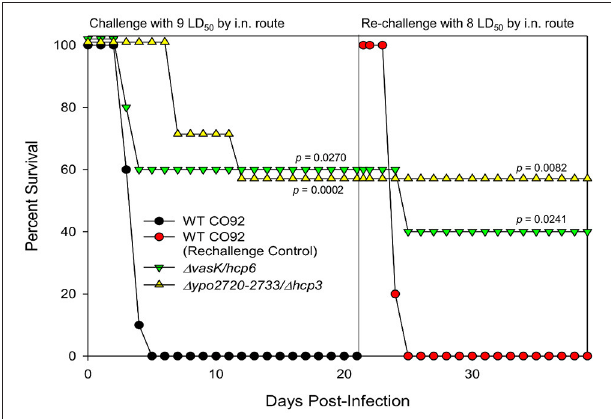
FIGURE 4 | Vaccine potential for selected Y. pestis CO92 combinational mutants . Female Swiss-Webster mice were challenged by the i.n. route with the WT CO92, 1 vasK 1 hcp6 , or 1 2720-2733/ 1 hcp3 ( n = 10) at 9 LD 50 and observed for mortality over a period of 21 days. Mice that survived the initial infection with the mutant strains and naive control animals ( n = 5) were challenged with 8 LD 50 of the WT CO92 strain. Survival data were analyzed for significance by Kaplan–Meier survival estimates. The P -values are for comparison of the results for the indicated strains to the corresponding result for WT CO92 (challenge experiment) or naive control challenged with WT CO92 (re-challenge experiment). Two independent experiments were performed and the data from the second set constituting a group size of 10 animals/group were